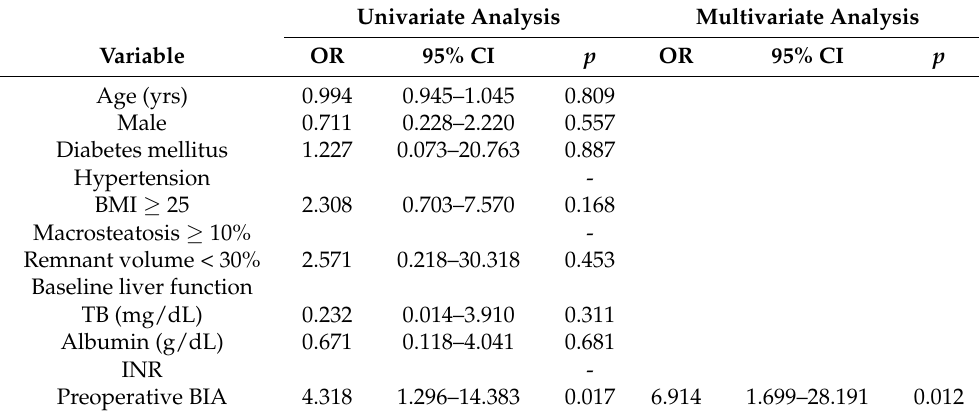
Table 3. Analysis of risk factors for cleaner surgical field. Univariate Analysis Multivariate Analysis